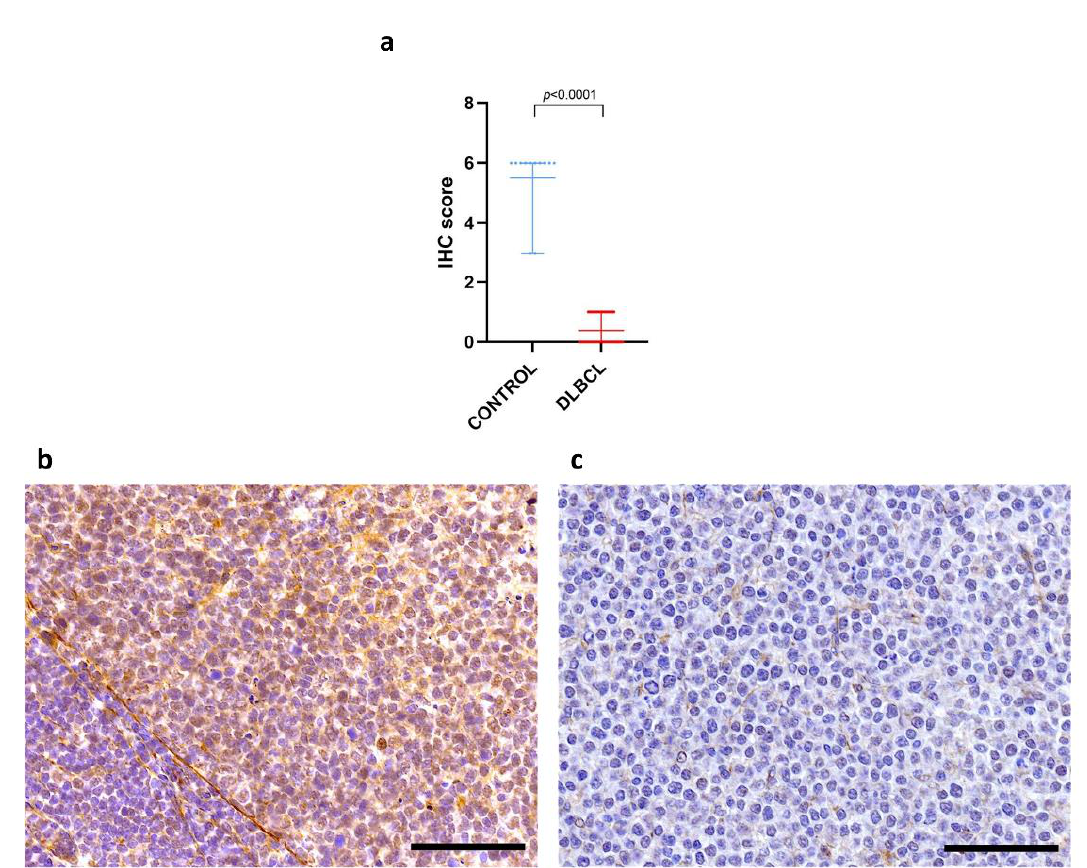
Figure 2. Immunohistochemical expression of IL-1R8 in DLBCLs and control lymph nodes. ( a ) Scatter plot of immunohistochemical semiquantitative score in control lymph nodes and canine DLBCL. Data are shown as individual values with mean and range. ( b ) Diffuse expression of IL-1R8 in germinal center B cells in a control lymph node. Immunohistochemistry for IL-1R8, 400 × magnification. Bar = 200 µ m. ( c ) Lack of IL-1R8 expression in neoplastic lymphocytes in cDLBCL. Immunohistochemistry for IL-1R8, 400 × magnification. Bar = 200 µm.